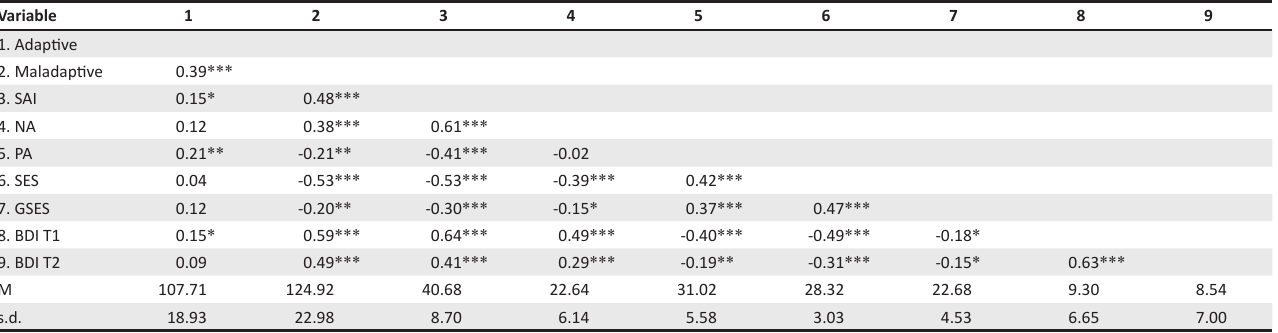
TABLE 2: Correlations (and partial correlations) between the dimensions of perfectionism and mental health.